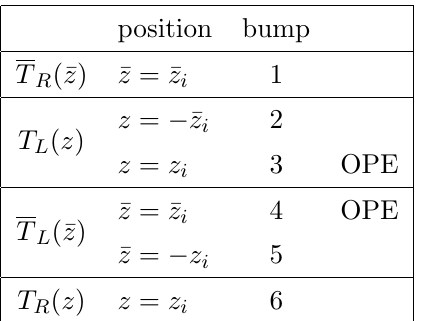
Figure 7 . The Penrose diagram associated to the time evolution of j O L ; D i to a time translation which makes explicit the time reversal invariance of the process. In the picture the operator is applied at t = 0. The wavy lines denote the bumps in the expectation value of the energy density, and the orange diamond denotes the support of the wave packet. The numbering of the lines refers to table 1.